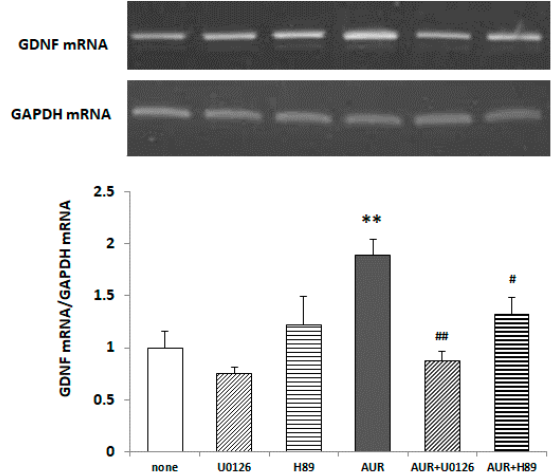
Figure 6. Effects of U0126 and H89 on AUR-induced GDNF mRNA content in C6 cells. Cells were preincubated with or without 10 µ M U0126 or 1 µ M H89 for 30 min and then incubated with 20 µ M AUR for 40 h. The results are presented as the mean ± SEM ( n = 4). Significance difference in values between the non-treated and AUR-treated cells: ** p < 0.05; significant difference in values between the AUR-treated and AUR/inhibitor-treated cells: # p < 0.05; ## p < 0.01.